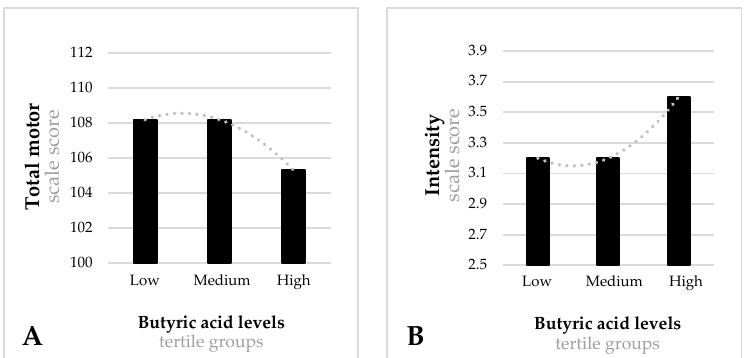
Figure 3. Total motor scale ( A ) intensity temperament scale ( B ) for tertile groups of butyric acid at the first trimester. ( A ) Low-tertile mean score = 109.1 (SD = 10.3), medium-tertile mean score = 108.1 (SD = 10.2), high-tertile mean score = 105.2 (SD = 13.9). Model F = 3.061; p = 0.048. ( B ) Low-tertile mean score = 3.3 (SD = 0.8), medium-tertile mean score = 3.2 (SD = 0.9), high-tertile mean score = 3.6 (SD = 0.9). Model F = 6.294; p = 0.002. Models adjusted for mother’s age, family’s socioeconomic status, first trimester state anxiety, smoking during pregnancy, first trimester quality of diet, first trimester BMI, mode of delivery, gestational age at birth, infant’s birth weight, infant’s sex, breastfeeding at 40 days postpartum, and bonding difficulties.